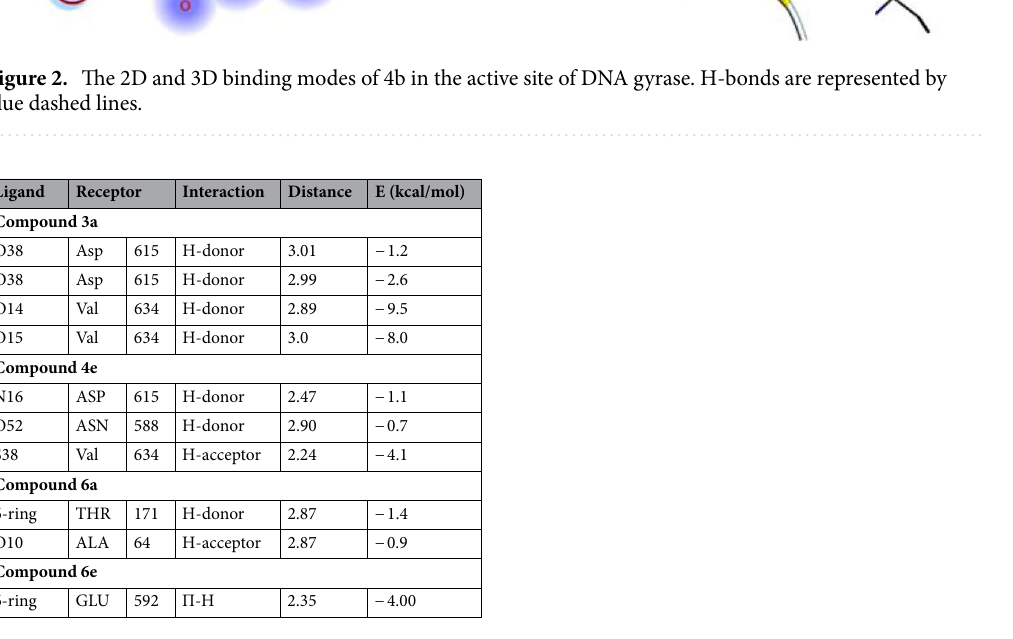
Table 2. Key interactions of the newly designed ligands with the active site of DNA gyrase B (PDB ID: